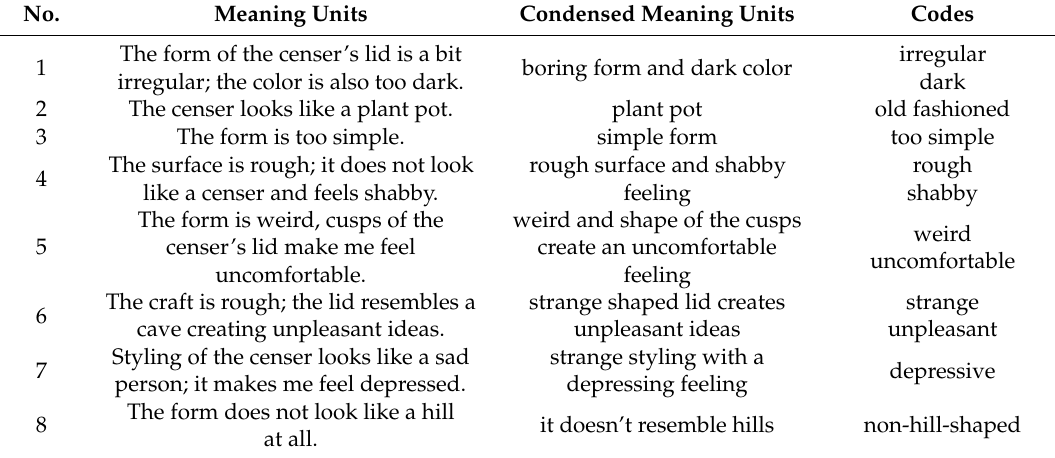
Table 3. Analysis of Unpleasant Features in Hill